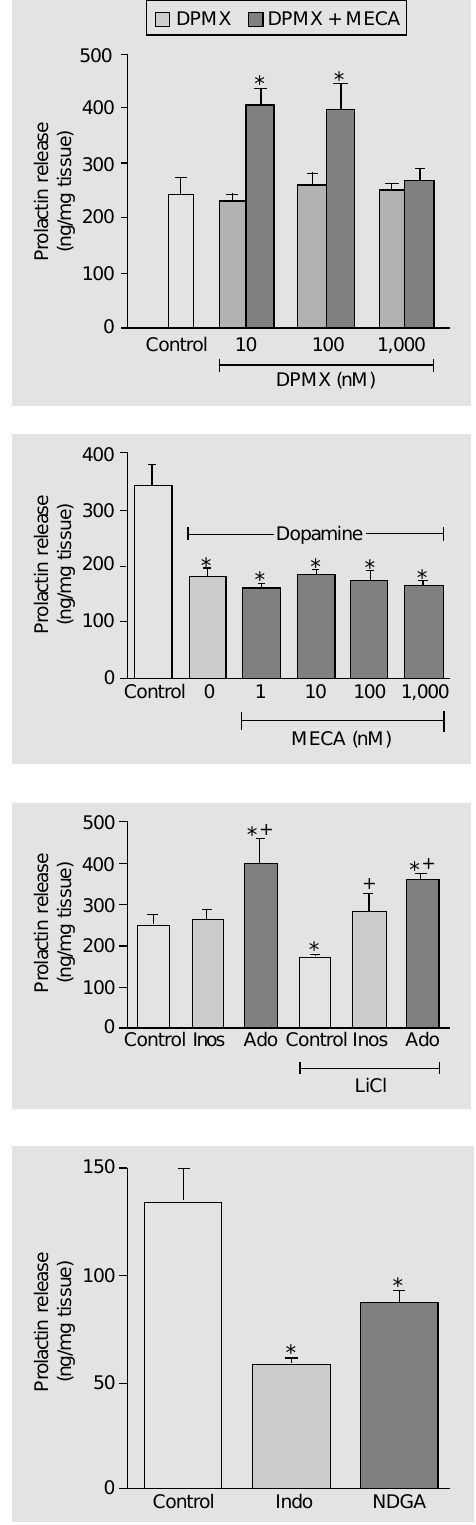
Figure 5. Effect of 10 µM in- domethacin (Indo) or 10 µM nor- dihydroguaiaretic acid (NDGA) on prolactin secretion. Data are reported as means ± SEM (N